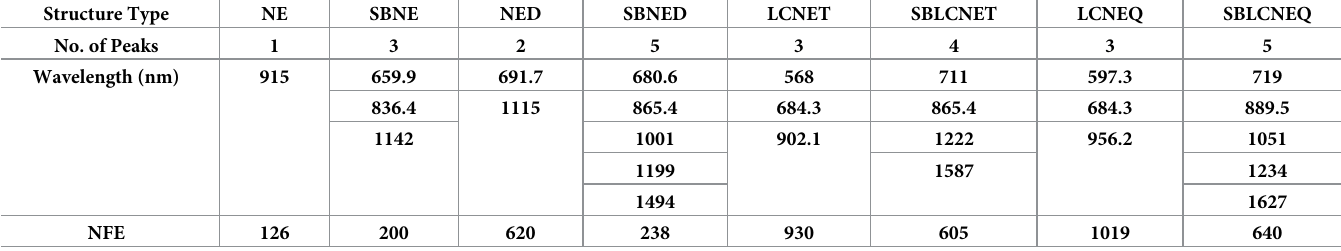
NFE While fixing a = 50 nm and b = 30 nm, thickness t = 25 nm for SBNE, SBNED, SBLCNET and